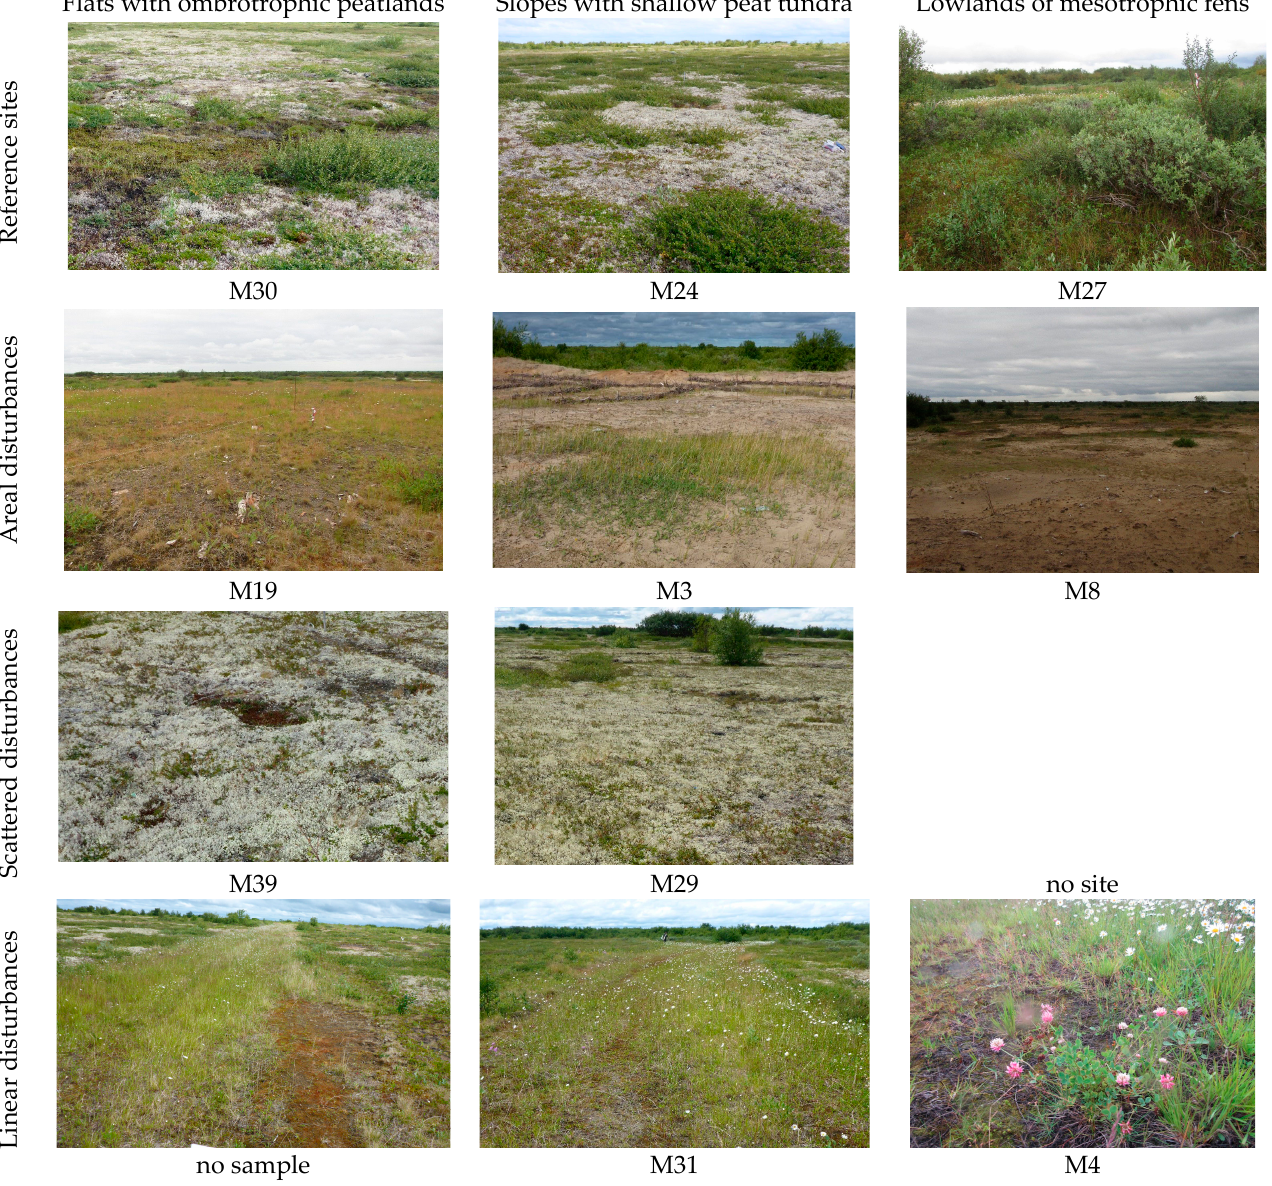
Figure 2. Characteristic types of micro-landscapes represented in the studied peatlands. The numbers indicate the monitoring plots.